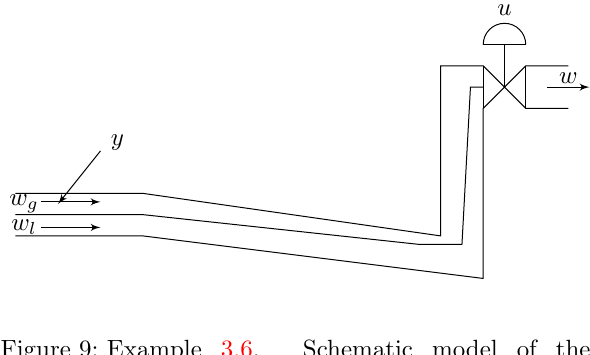
Figure 9: Example 3.6. Schematic model of the pipeline-riser, viz. the plant in the feedback system in Figure 1.